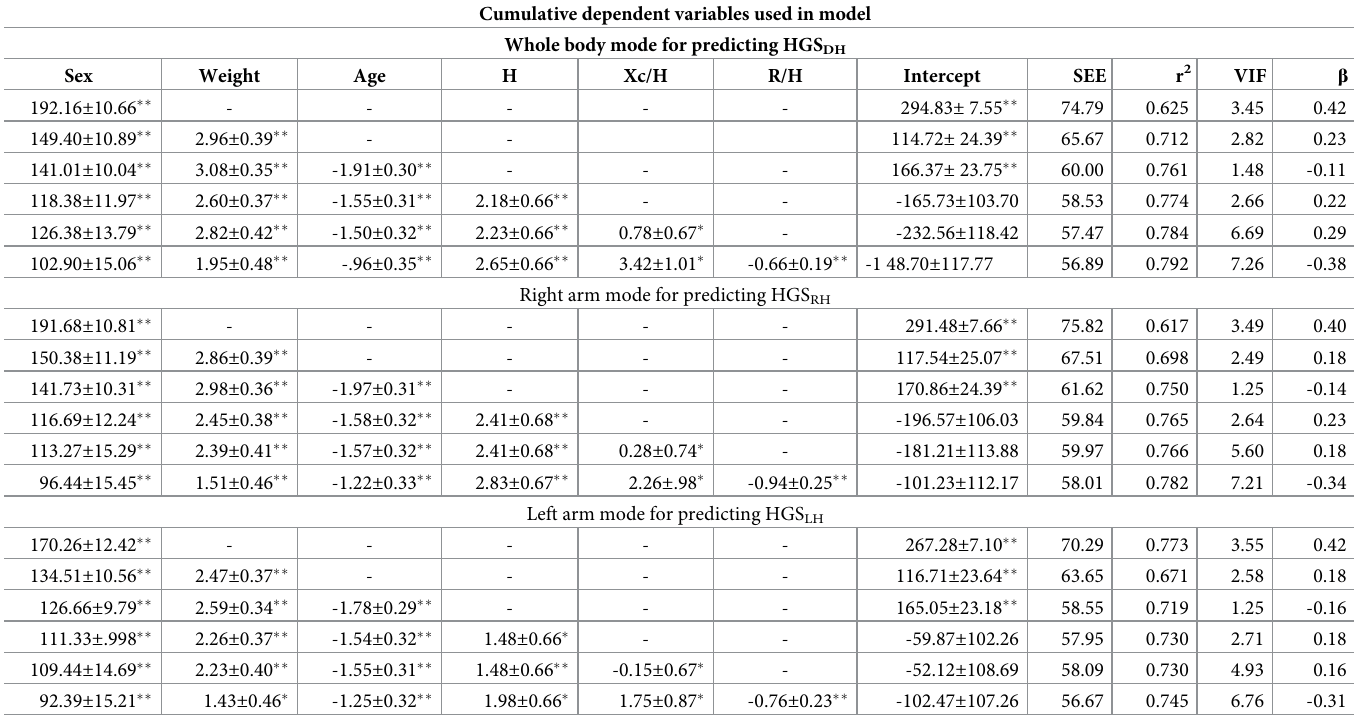
Table 3. Multiple regression analyses for predicting handgrip strength in the dominant, right, and left hands. Cumulative dependent variables used in